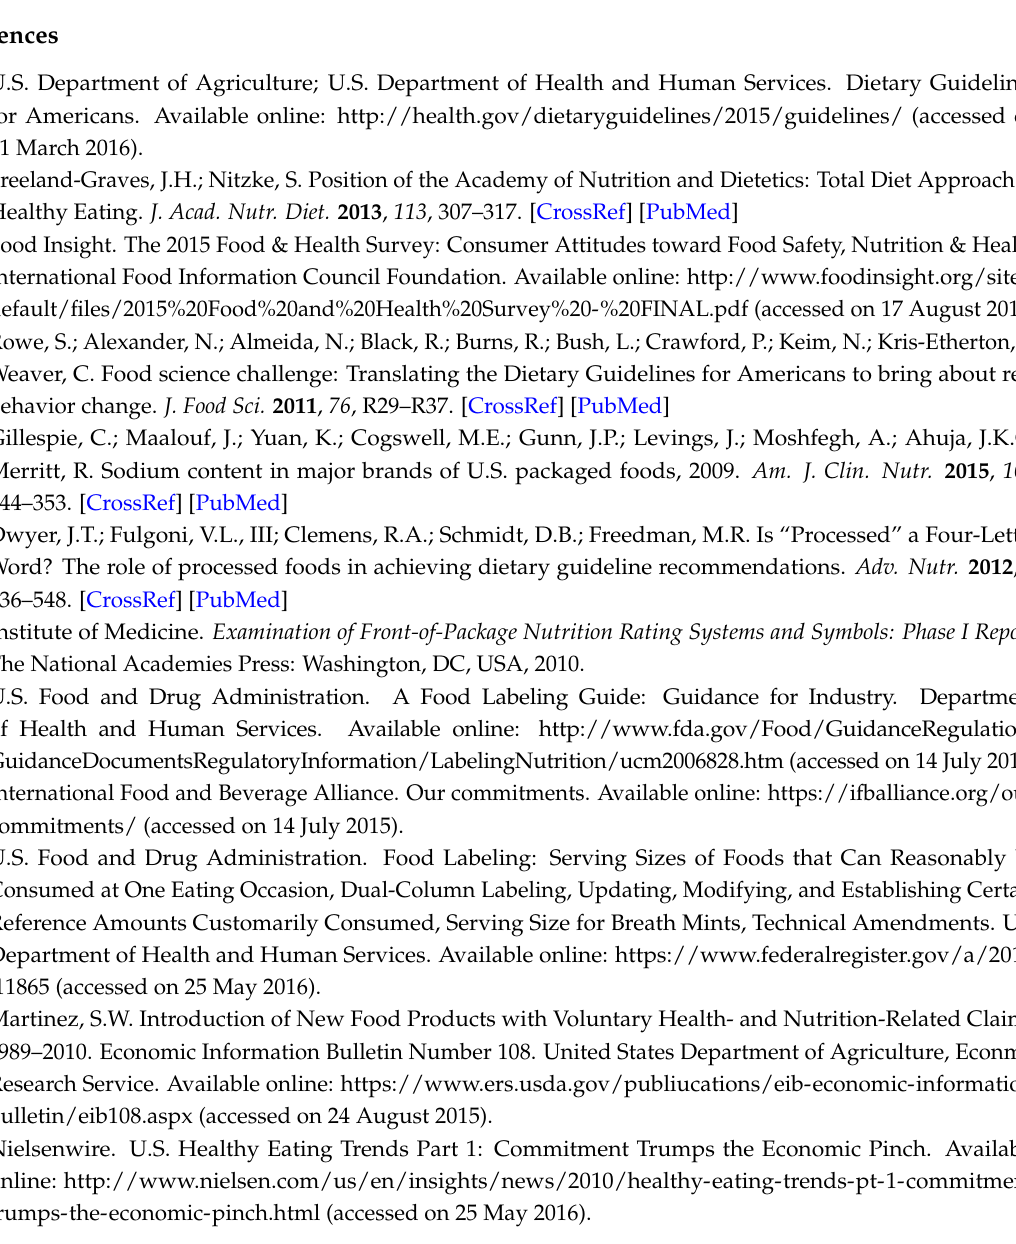
Figure S1: Flow diagram depicting selection process for food categories, Figure S2: Websites used to collect nutrition data for regular and modified foods identified in the top 10 brands within the four food categories, Figure S3: Flow diagram depicting derivation of product nutrition information, Table S1: Serving size (g) by food category for regular and modified foods, Table S2: Mean calorie, sodium, total fat, and saturated fat by food category for regular and modified foods, where each regular food product was randomly matched to one modified